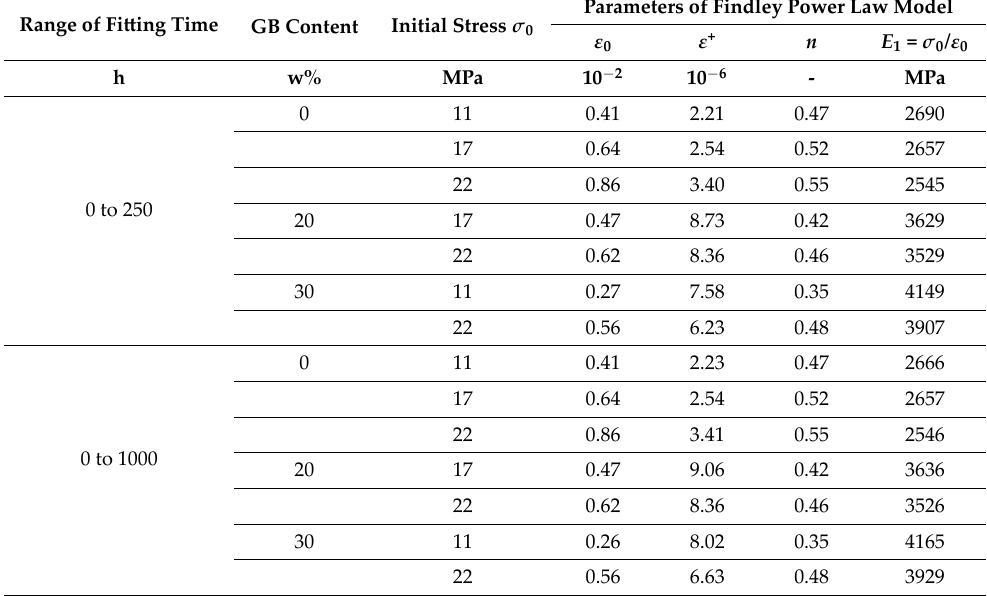
Table 3. Initial stress‑dependent parameters of Findley power law model according to fitting